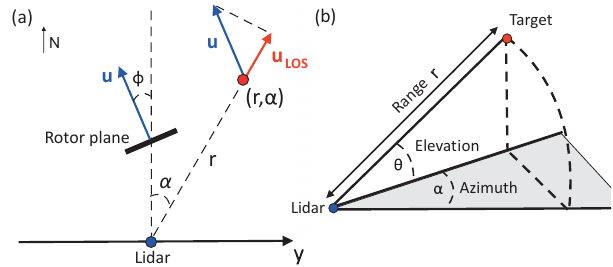
Figure 4. (a) Plan view of the coordinate system for scanning lidar PPI scans; (b) 3-D sketch of the main geometric quantities relevant in a lidar